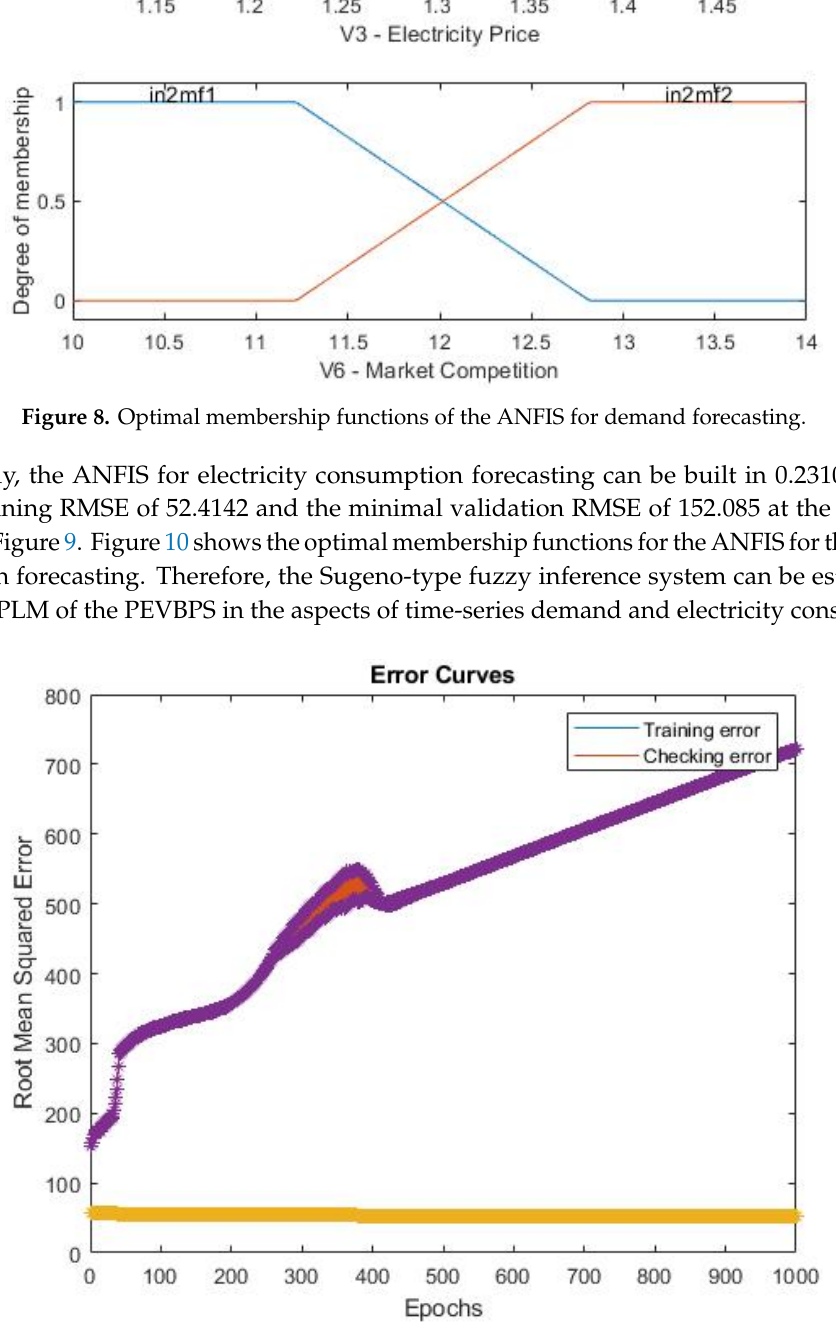
Figure 9. Error measurement for training and validation for electricity consumption forecasting.